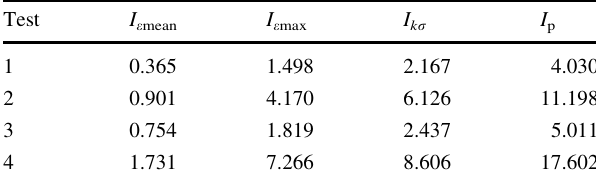
Table 7 Consistency evaluation of the short-circuit currents in Sys- tem B (%)